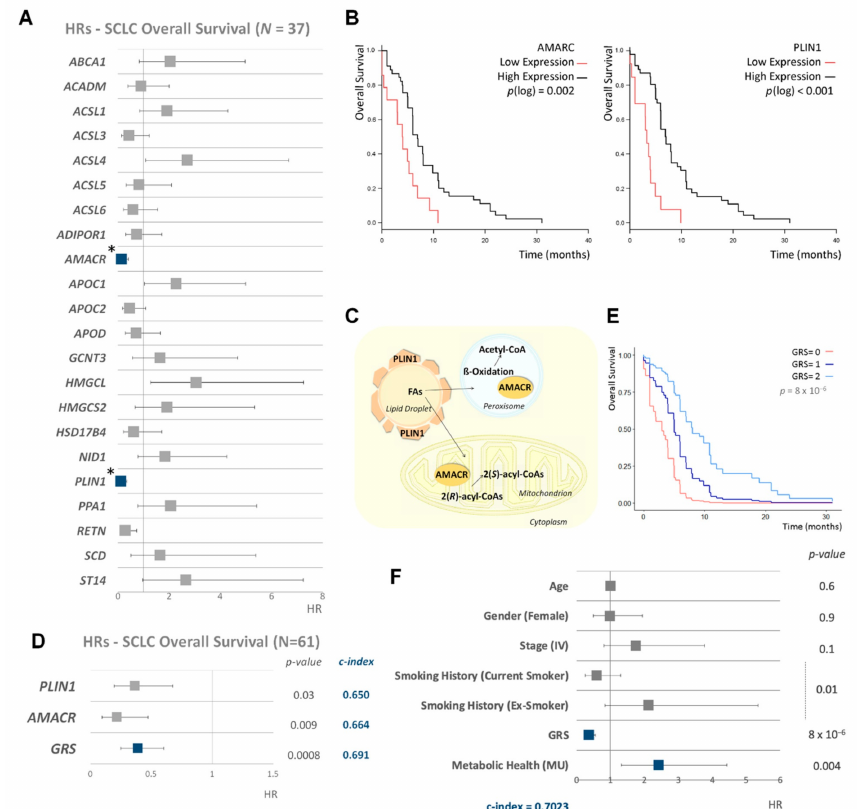
Figure 2. Impact of lipid metabolism and metabolic health on the survival of small cell lung cancer (SCLC) patients. ( A ) Forest plot showing the hazard ratio (HR) and 95% confidence interval (CI) estimates for the overall survival (OS) of lipid metabolism binarized gene expression in 37 SCLC patients from our dataset. Multivariable Cox regression model was used to estimate the hazard ratio of gene expression, and adjusting for potential confounding factors: age, sex, stage and smoking status. p .values were obtained from marginal likelihood-ratio tests of each factor and corrected by Bonferroni method. ( B ) Kaplan–Meier plots for racemase ( AMACR ) and perilipin 1 ( PLIN1 ) expression in 61 SCLC patients. Each gene expression variable was binarized by determining a cutpoint based on maximally selected rank statistics and using Log-rank scores. p(log): p -value Log-rank from log-rank test. ( C ) Schematic representation of intracellular functions of AMACR and PLIN1 enzymes. ( D ) Forest plot showing the hazard ratio (HR) and 95% confidence interval (CI) estimates for overall survival (OS) of AMACR and PLIN1 expression and genetic risk score (GRS) for both genes in SCLC. Multivariable Cox regression model was derived to estimate the hazard ratio of gene expression and adjusting for potential confounding factors. The Bonferroni method was applied for the multiple test correction of the p -values. ( E ) Conditionally adjusted survival curves for SCLC overall survival by lipid GRS. ( F ) Forest plot showing the hazard ratio (HR) and 95% confidence interval (CI) estimates for the overall survival (OS) of clinical characteristics, lipid GRS and metabolic health status in 61 SCLC patients. HR, their 95%CI and p -values were calculated from multivariable Cox regression model. p .values were obtained from marginal likelihood-ratio tests of each factor and corrected by Bonferroni method. MU: metabolically unhealthy patients. * Adjusted and corrected p -value <